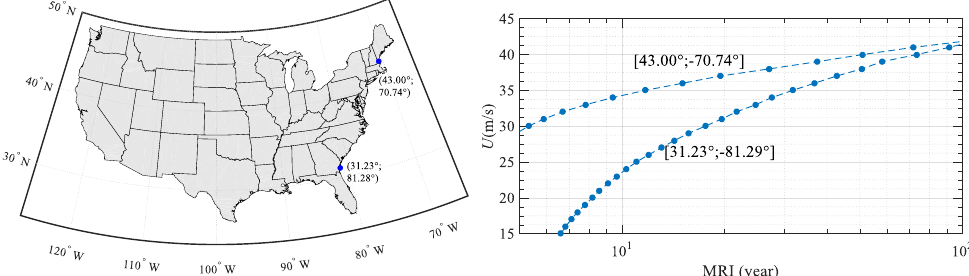
Figure 8. Location of the two selected points ( left ) along with 𝑀𝑅𝐼 distribution of wind speed (at 10 m height) ( right ). 10 m height) ( right